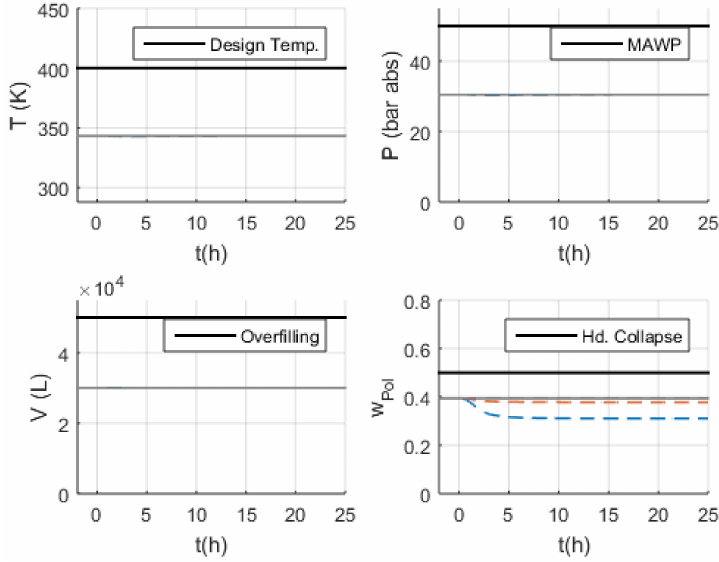
Figure 21. Behavior of critical variables in scenarios S-13 and S-14 with Model 1. Inlet TEA mass